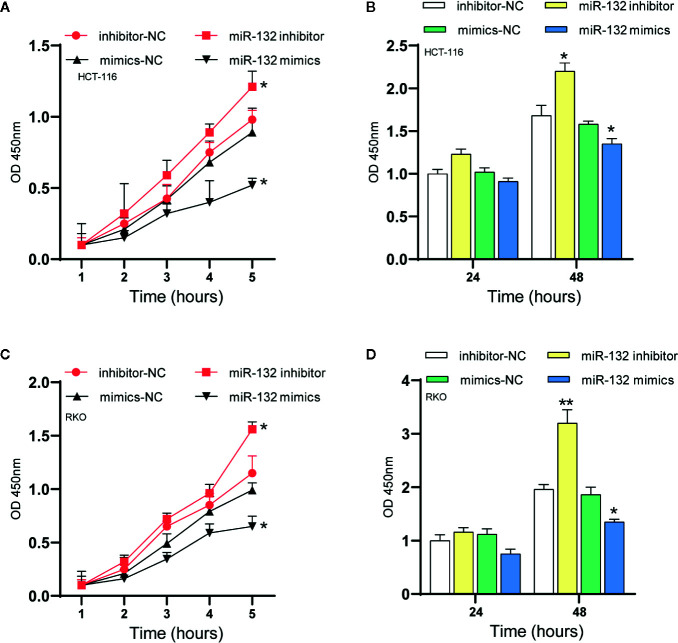
MiR-132 suppresses CRC cell proliferation. (A, B) The HCT-116 cell viability after miR-132 overexpression or knockdown was detected using CCK-8 assay. (C, D) The RKO cell viability after miR-132 overexpression or knockdown was detected using CCK-8 assay. *P < 0.05, **P < 0.01.